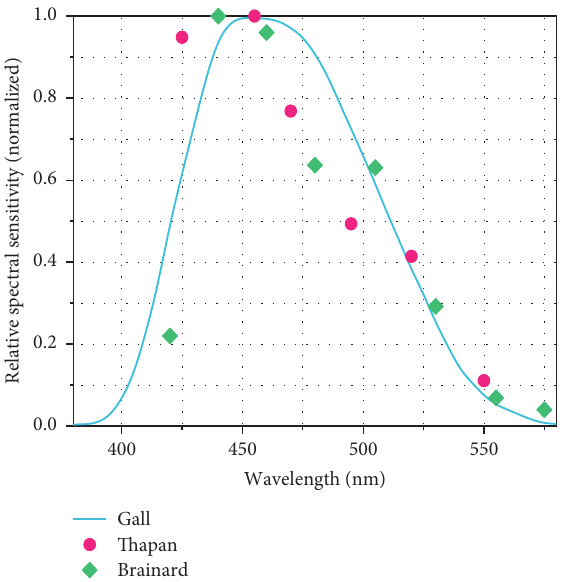
Figure 4: Nonvisual biological effects